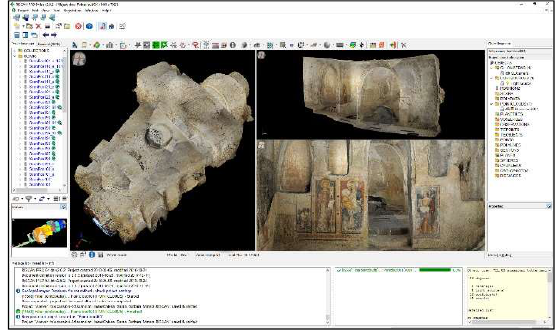
Figure 1: Sw RiscanPro. Point cloud model by laser scannings.